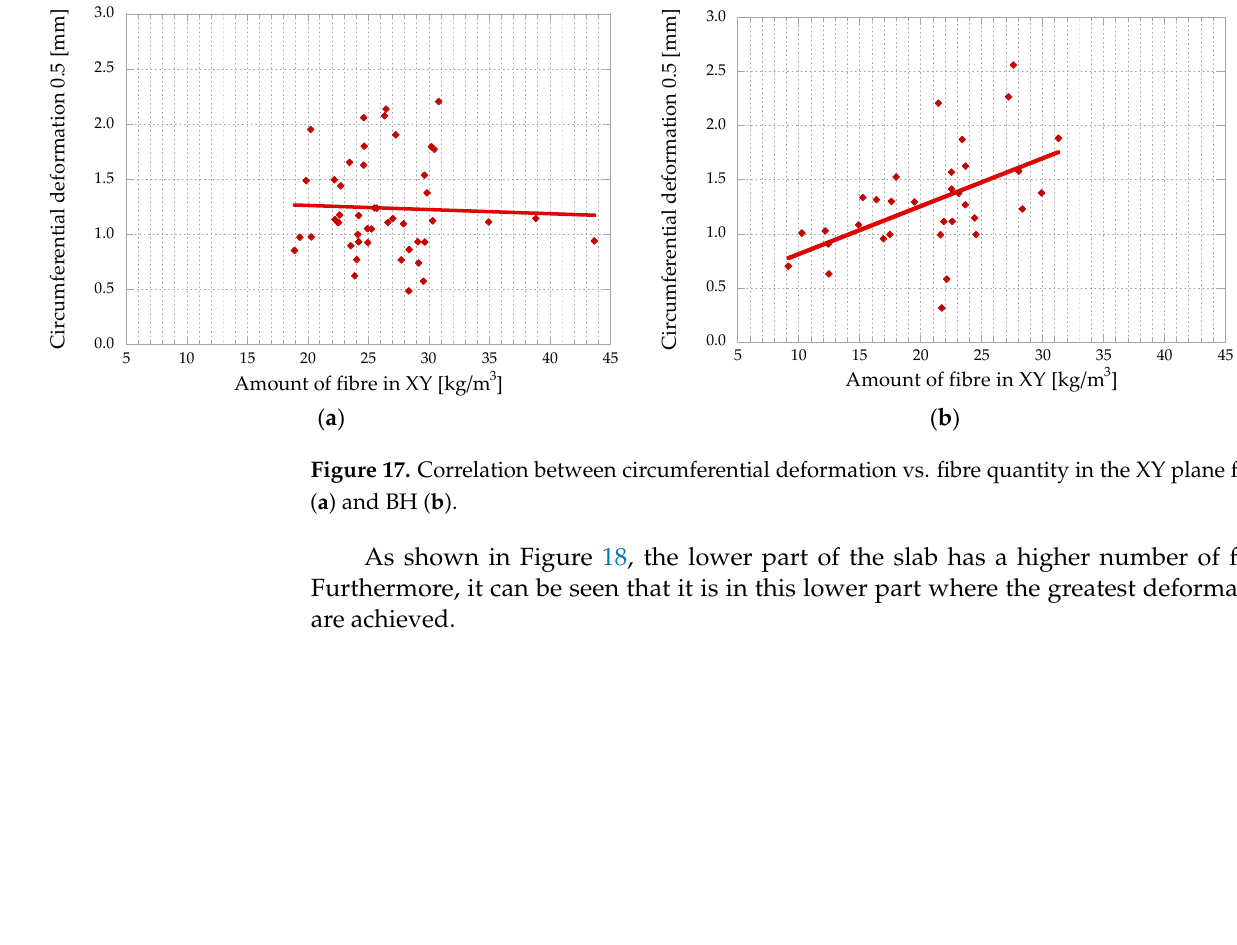
tity in the XY plane for both types of pouring directions.